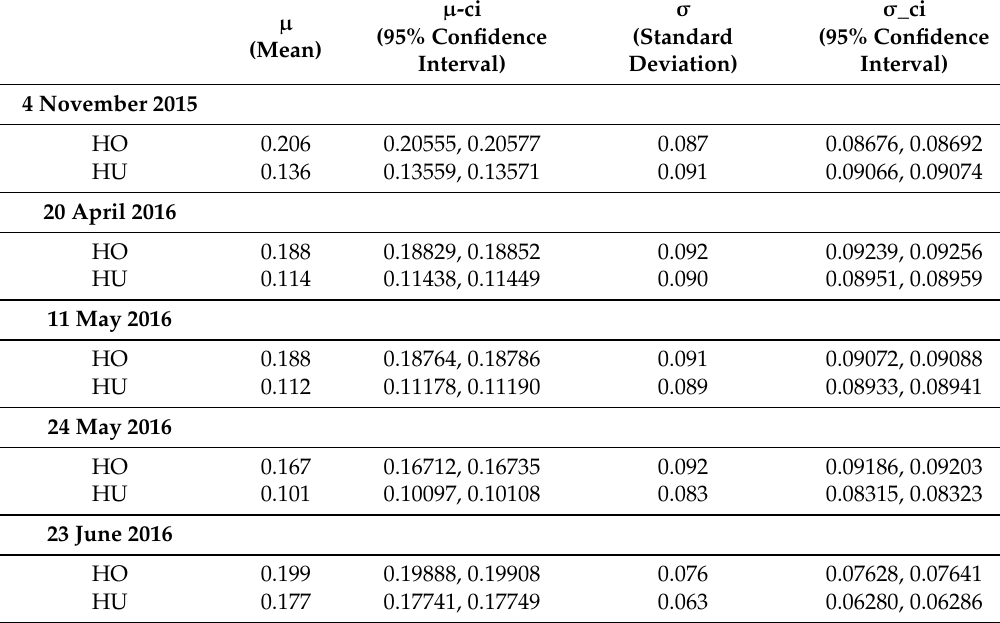
Table A1. Normal probability density function parameters for the hummock (HU) and hollow (HO) GWC